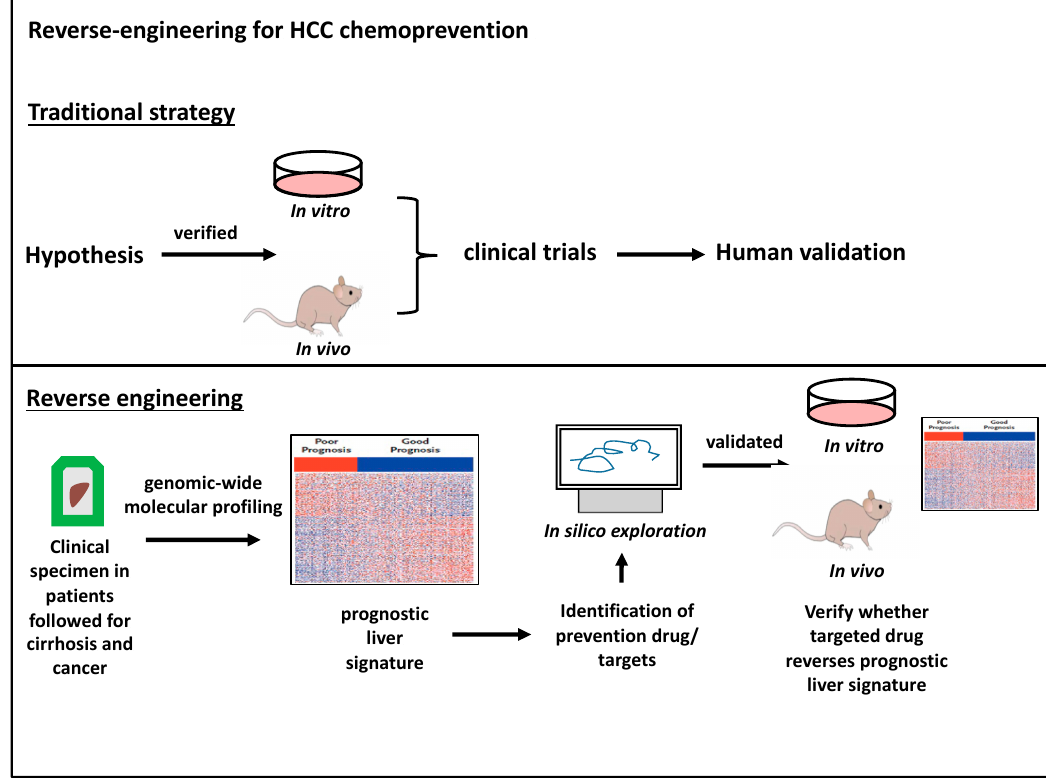
Figure 2. Reverse engineering for HCC chemoprevention. Traditionally, chemoprevention targets are verified in both in vitro and experimental animal models and then introduced into clinical trials (top panel). The reverse-engineering identifies targets for chemoprevention in human cohorts already followed for decades. Samples are genetically profiled into molecular signatures and then experimentally evaluated for mechanisms and therapeutic strategies (bottom panel).